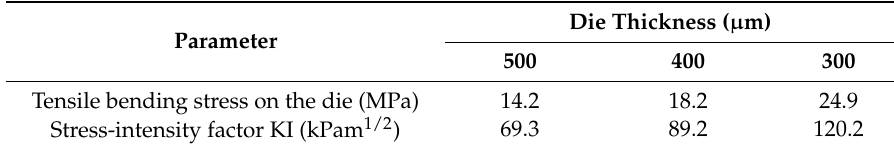
Table 5. Influence of die thickness on thermo-mechanical reliability for packages with flexible substrate ( ∆ T = 100 ◦